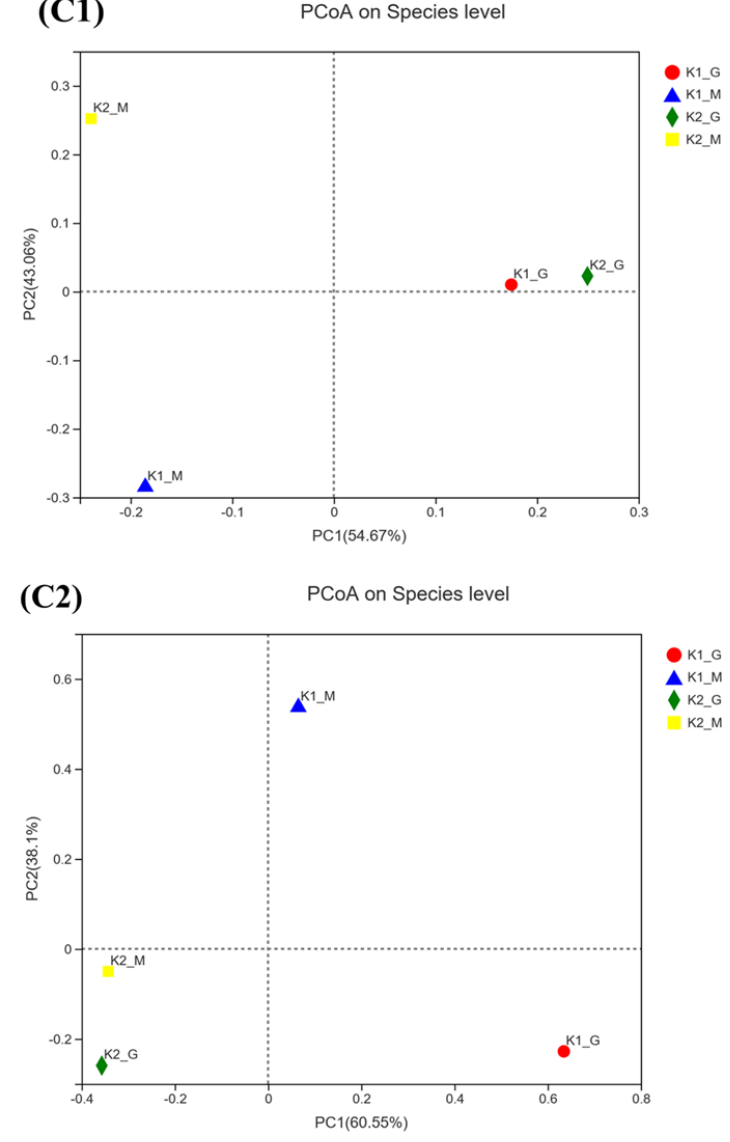
Figure 2. Venn diagram ( A1 , A2 , A3 , A4 ), relative abundance ( B1 , B2 ) and PCoA score plots ( C1 , C2 ) on bacterial species and fungal genus community in K1 and K2. The odd number represent bacterial species; The even represent fungal species; ( A1 ) and ( A2 ) represent K1; ( A3 ) and ( A4 ) represent